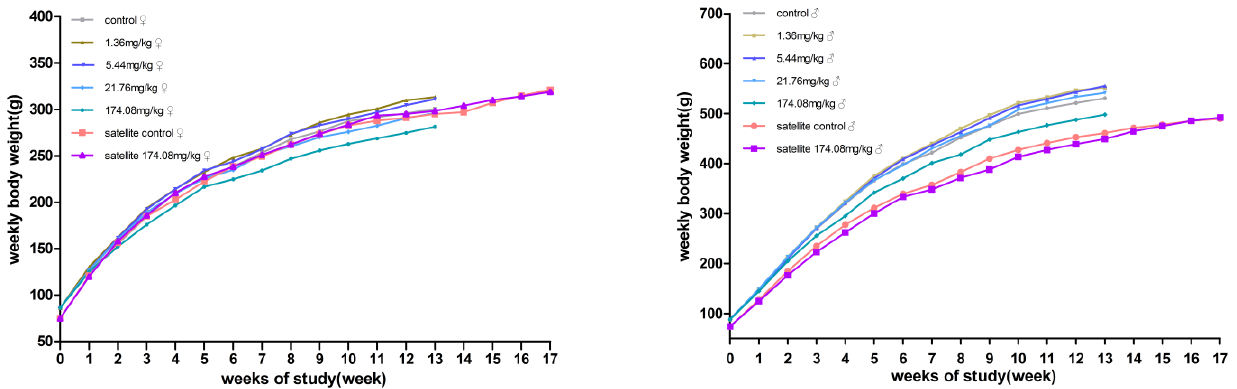
Figure 3. Average daily food consumption of the rats orally administered AQ for 90 days. ( Left ) female; ( Right ) male.